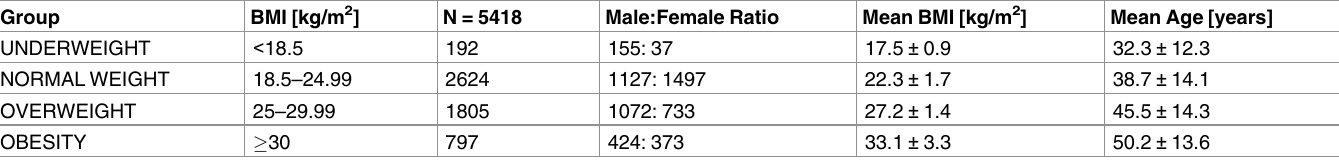
Table 1. Characterization of the study group (N = 5418).